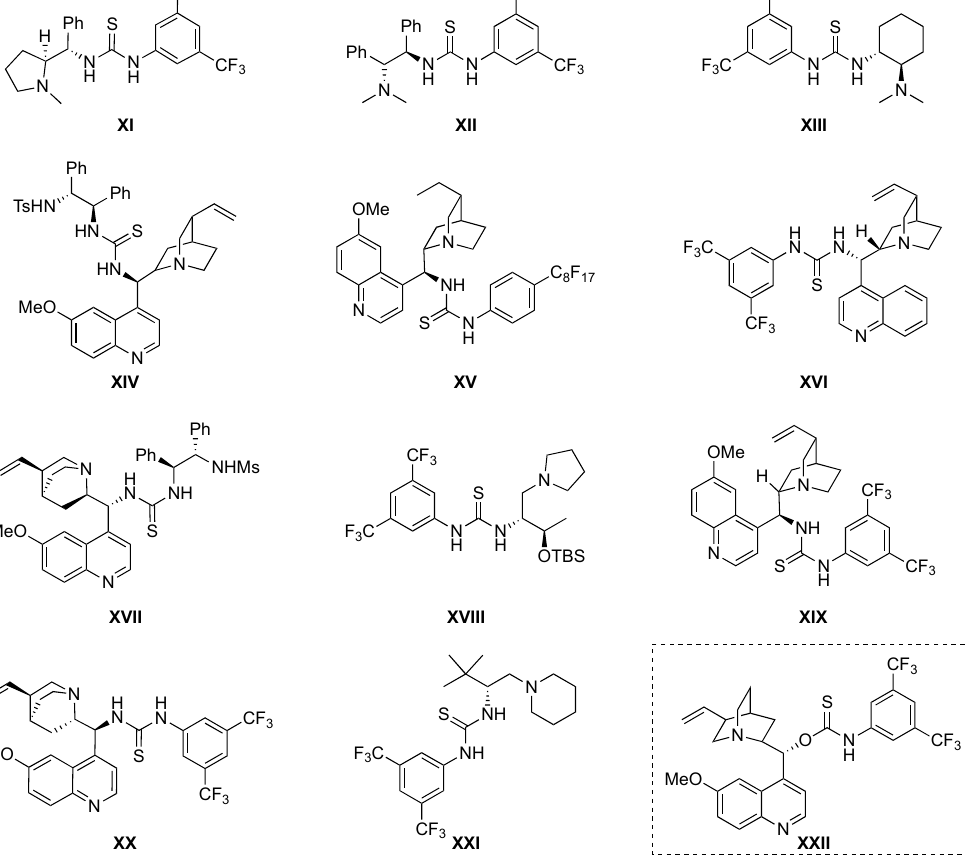
Figure 4. Thiourea and thiocarbamate organocatalysts used in this section.